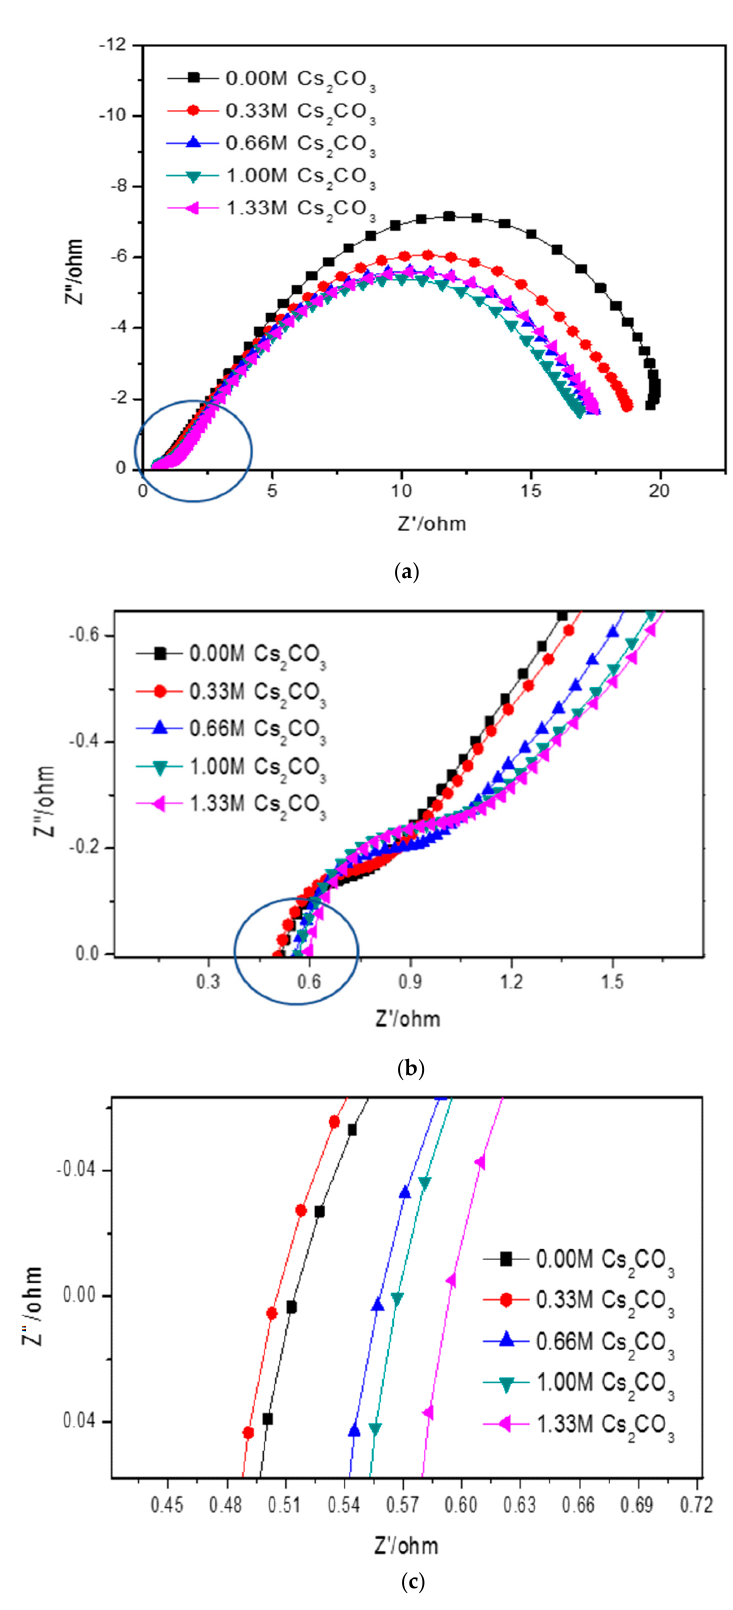
Figure 6. ( a ) Full Cole–Cole plots of AR3 in the 6.77 M KOH, 6.44 M KOH + 0.33 M Cs 2 CO 3 , 6.11 M ( b ) magnification of the circled section in ( a ), and ( c ) magnification of the circled section in ( b